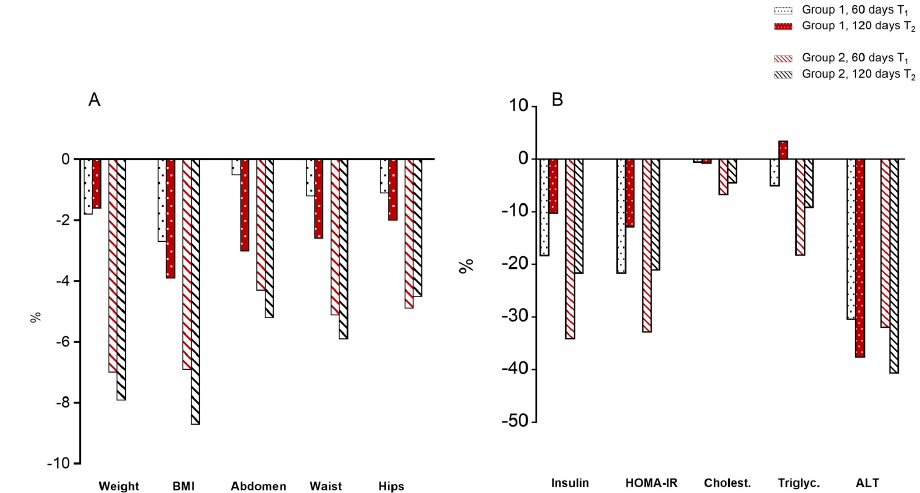
Figure 1. Percentage changes of anthropometric measures ( A ) and serum biochemical parameters ( B ) at 60 and 120 days compared to baseline (T0) (see study design). White = RCR; Red = RCR + tomato. Statistically significant di ff erences are reported in Tables S3 and